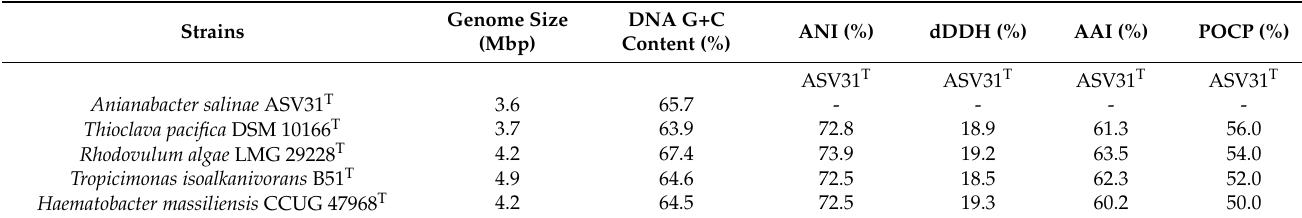
Table 3. Genomic features of strain ASV31 T and its closely related taxa, and OGRI values obtained after their genome comparison with the ASV31 T genome. Data are from this